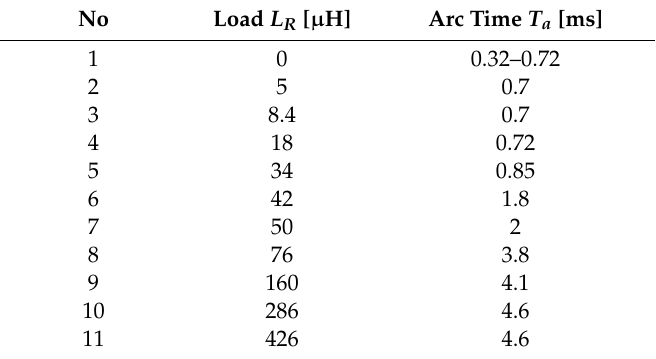
Table 2. E ff ect of serial inductance of arc branches on arc